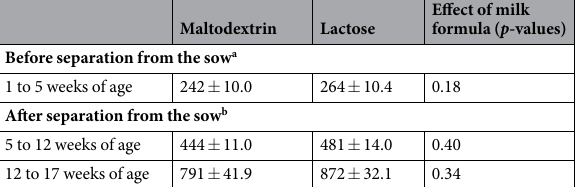
Table 2. Average daily gain (ADG, g/d) of piglets fed milk formulas containing lactose or maltodextrin as the only carbohydrate source from 1 to 9 weeks of age. a n = 4 litters per treatment. b n = 8 pens (of 3 to 4 piglets) per